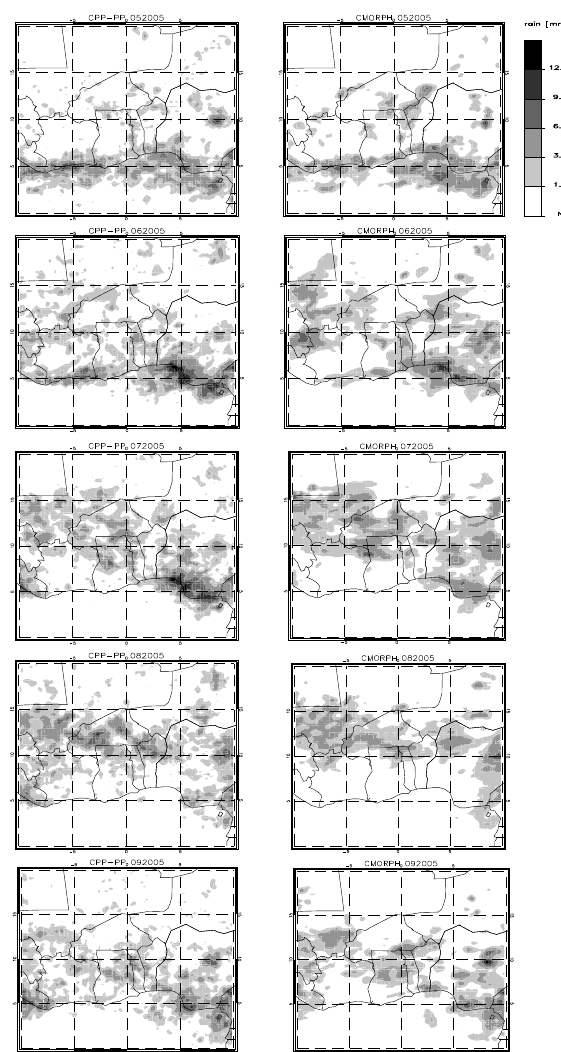
Fig. 5. Mean accumulated daily precipitation (expressed in mm d − 1 ) for May–September 2005 from (left) CPP-PP and (right) CMORPH. For both datasets observations at 09, 12, and 15 UTC were included. See text for further details.